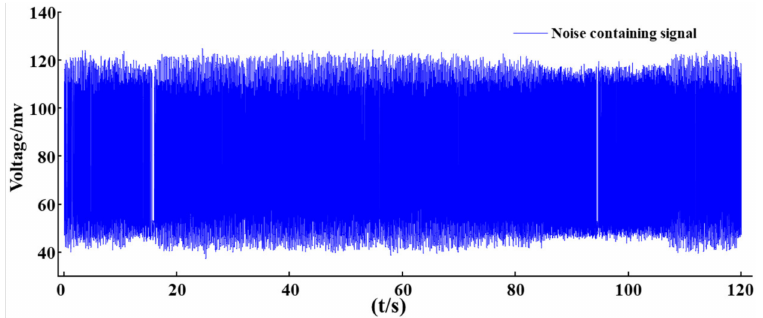
Figure 4. PID original